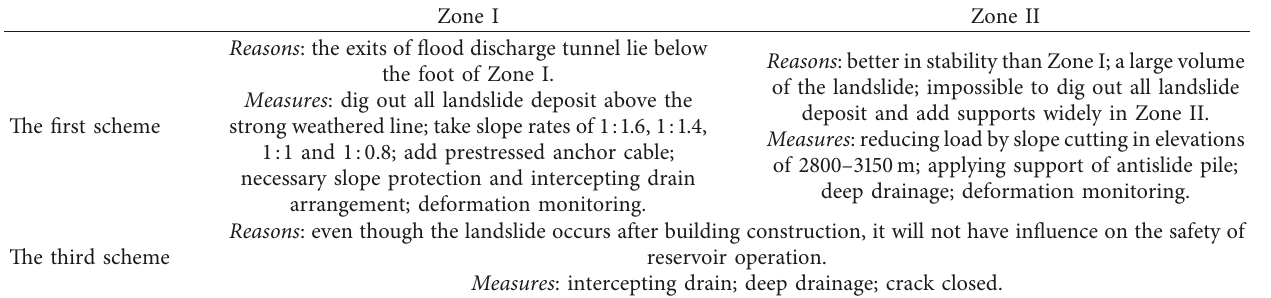
Figure 20: The total displacement of the whole landslide deposit. Table 4: Treatment designing for landslide